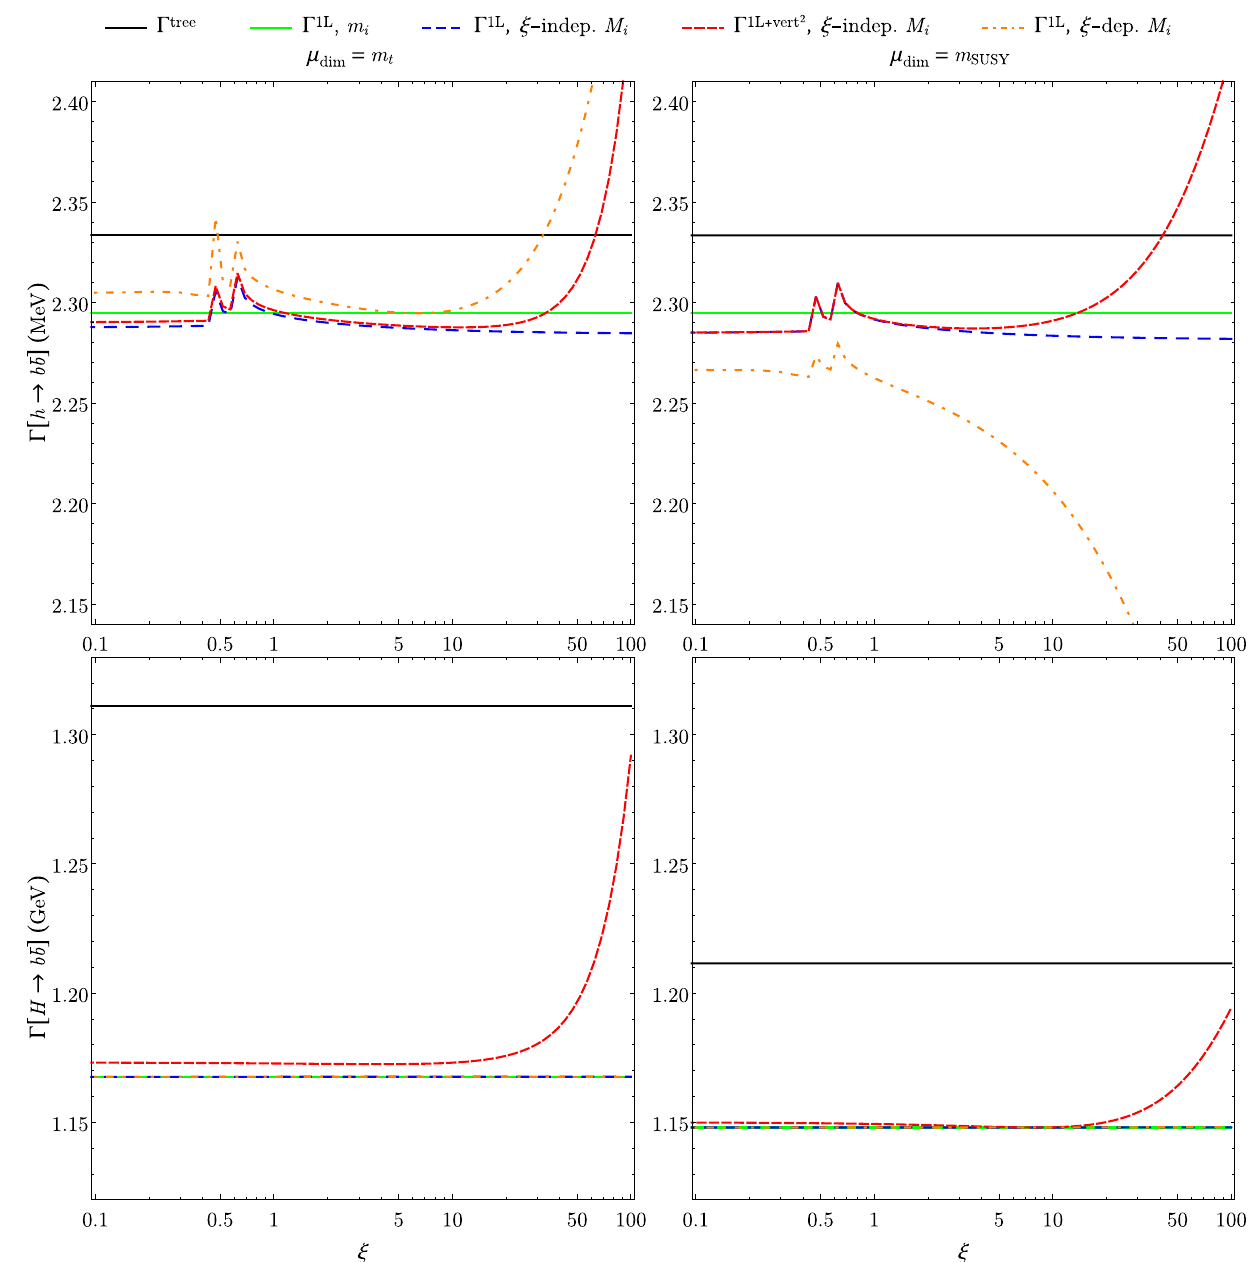
Fig. 2 The ξ -dependence in the Higgs decay widths into b ¯ b is shown in the scenario of Fig.1. The solid black curve represents the QCD- corrected tree-level width, while the solid green line corresponds to a full one-loop calculation where the one-loop functions are evaluated at the tree-level value of the Higgs mass. In both cases, the kinematics employs the loop-corrected mass of Eq.(4). For the dashed blue curve, this same loop-corrected mass is also used in the one-loop functions. In